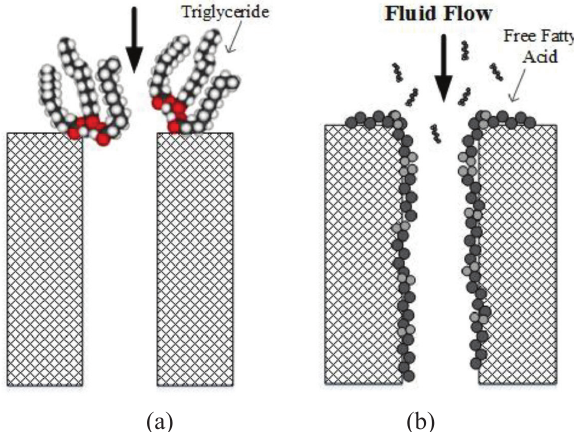
Fig. 8 – Schematic illustration of (a) intermediate blocking and (b) standard blocking mechanisms in UF of the CPO-iso- propanol